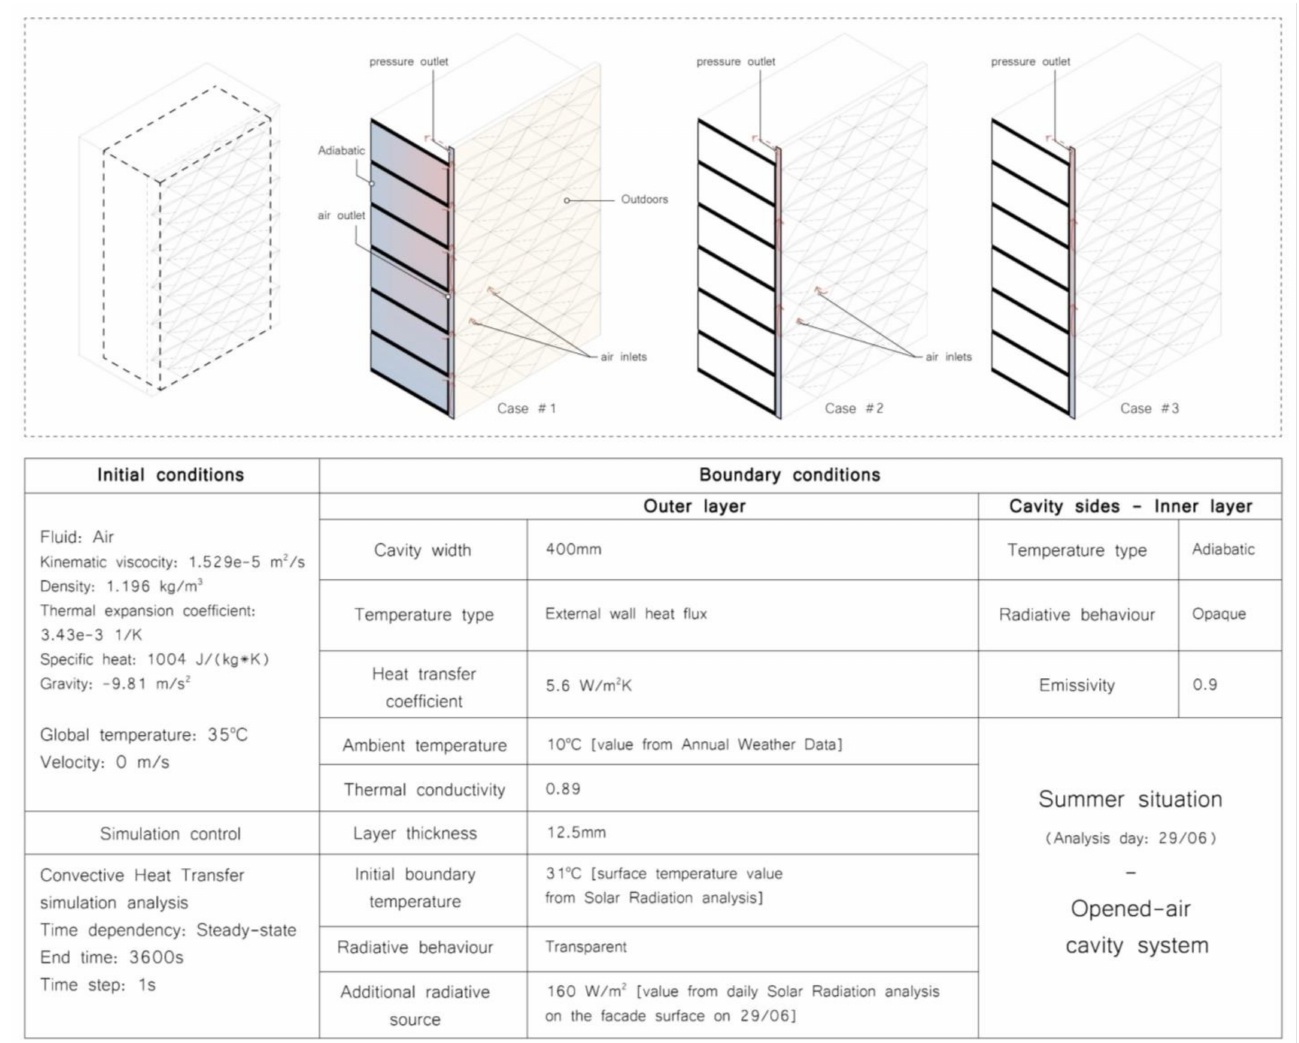
Figure 16. Overview of the input parameters and boundary conditions for the SimScale CFD convec- tive heat transfer analysis in the summer